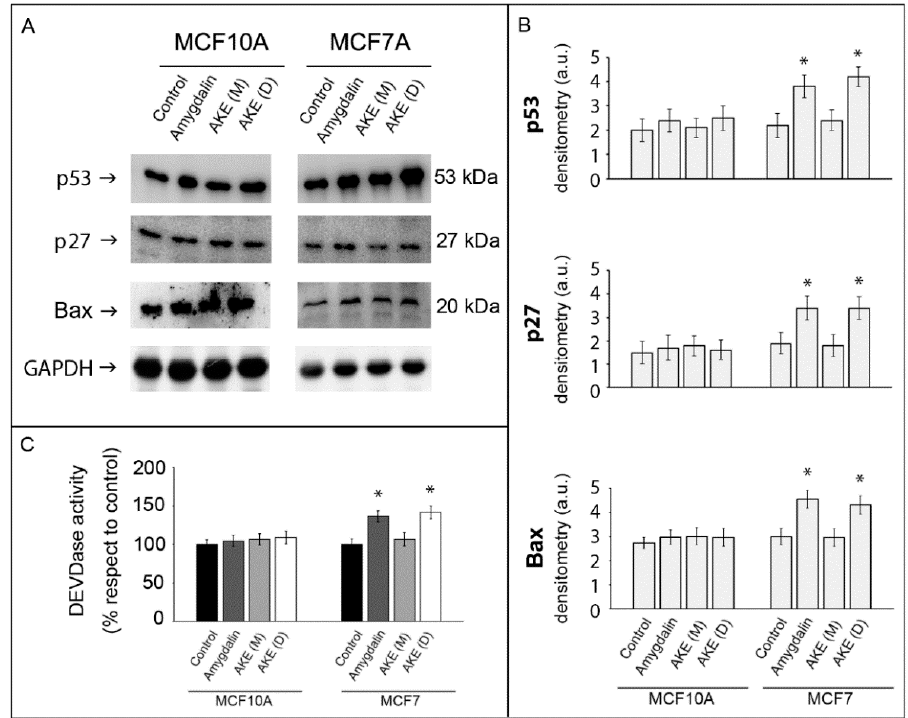
Figure 4. Effect of amygdalin and apricot kernel extracts on apoptosis markers. Representative Western blot of p53, p27, and Bax (Panel ( A )) and relative densitometry (Panel ( B )). GAPDH was used as equal loading control. Results are expressed as mean values and standard deviation and are obtained from five separate experiments. * p < 0.05 indicates significantly different values compared with respective untreated control cells. ( C ) DEVDase activity was measured in normal and cancer cells following 24 h treatment with 50 μ M amygdalin and 1 mg/mL apricot kernel extracts. Asterisks indicate significantly different values compared with respective untreated control cells (* p < 0.05). Results are expressed as mean values and standard deviation and are obtained from five separate experiments. Statistical analysis was performed with one-way ANOVA, followed by the Bonferroni test using SigmaStat 3.1